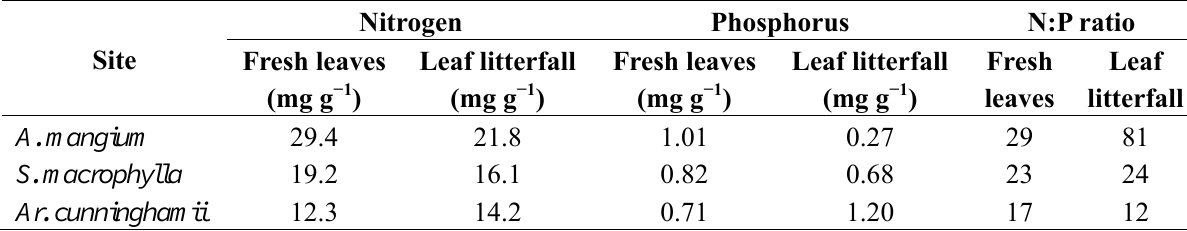
Table 1. N and P concentrations in fresh leaves and leaf litterfall and N:P ratio in the three